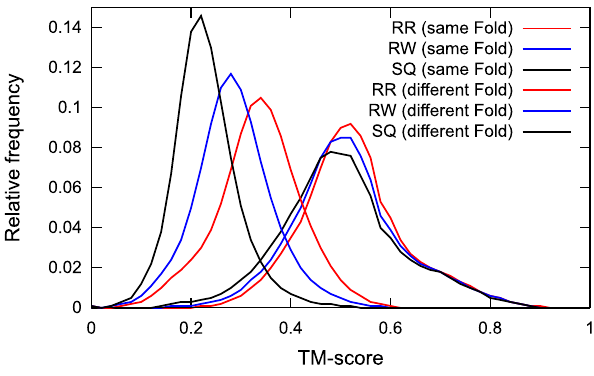
Figure 12. Comparison of the TM-scores among the best SQ, RW, or RR template and the corresponding query. The histograms of the TM-scores of the SQ, RW, and RR templates are represented as black, blue, and red lines,